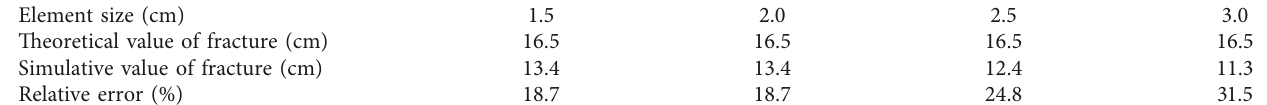
Table 2: Sensitivity of mesh size on the fracture of plate.